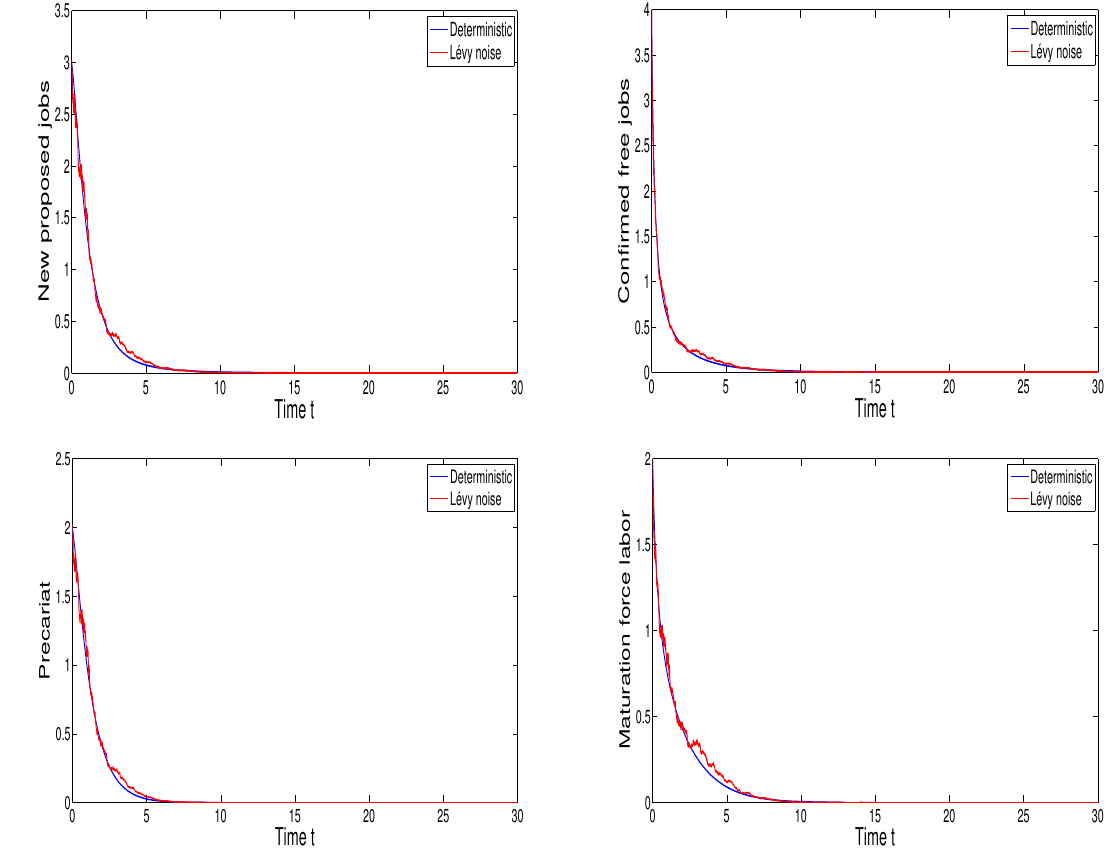
Figure 1. The behavior of free jobs and the labor force. Figure 2 represents the behavior of u 1 , u 2 , v 1 , and v 2 . We remark that the labor force is extinct and the free jobs stay non negative; this means that the population of the labor force will be extinct and the free jobs will persist.